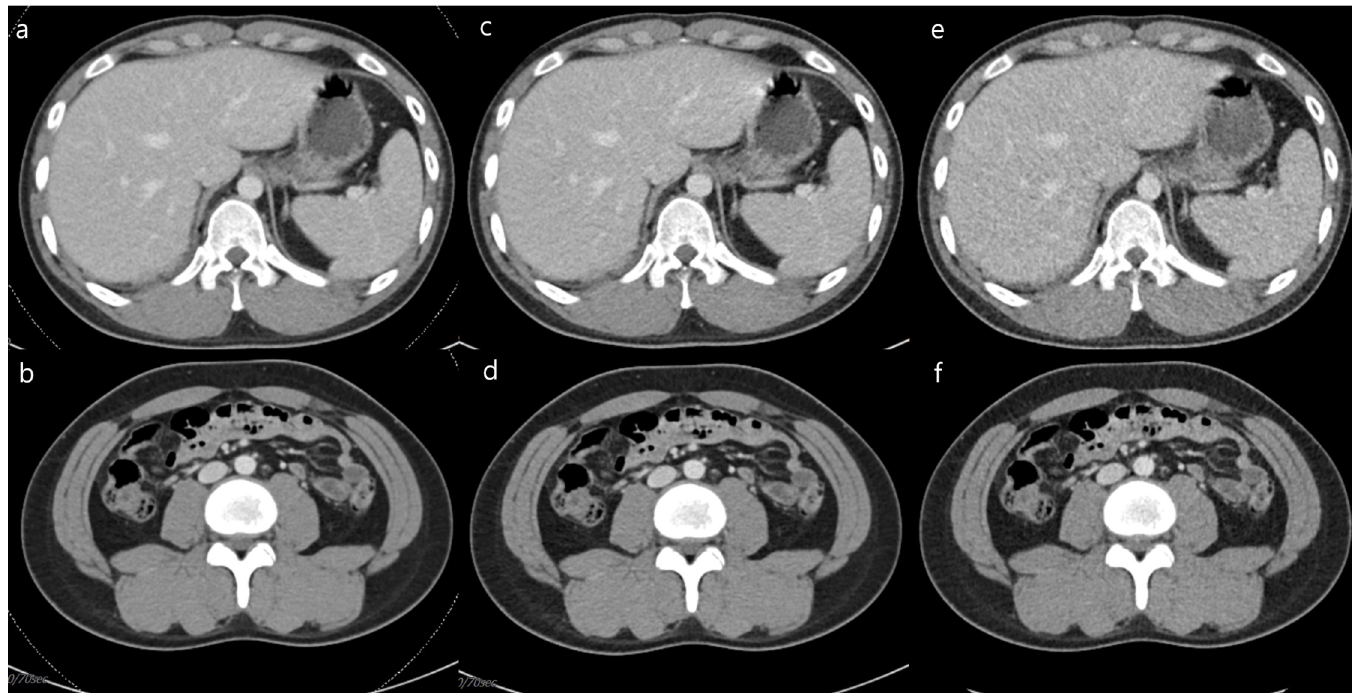
Fig 2. Abdominopelvic computed tomography (CT) images of a 23-year-old woman with Hodgkin’s lymphoma, complete remission state (body mass index, 24.2 kg/m 2 ; effective diameter, 24.0 cm). The three different types of CT images, acquired according to the radiation dose (a-b: standard-dose CT, 5.6 mSv; c-d: low-dose CT, 3.7 mSv; e-f: ultralow-dose CT, 1.8 mSv), show the absence of enlarged lymph nodes and splenomegaly. Identical reports of the aforementioned features were also obtained from two radiologists. The overall image quality score was 4 for the ultralow-dose CT images and 5 for the low-dose and standard-dose CT images, according to three readers (two radiologists and one